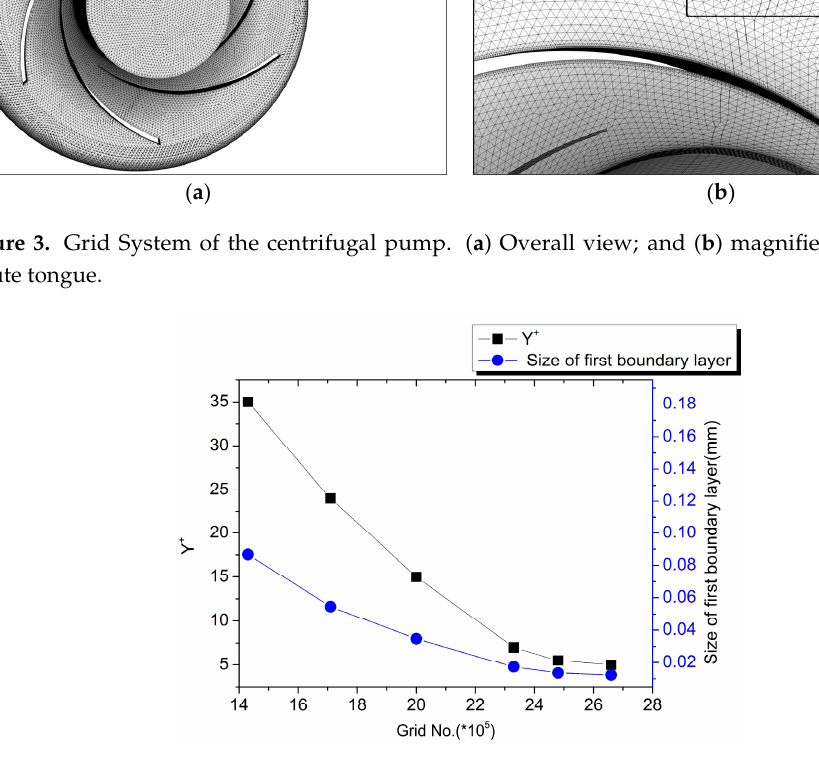
Figure 4. Y + values and corresponding sizes of first boundary layer. Table 2. Grid independent Analysis.